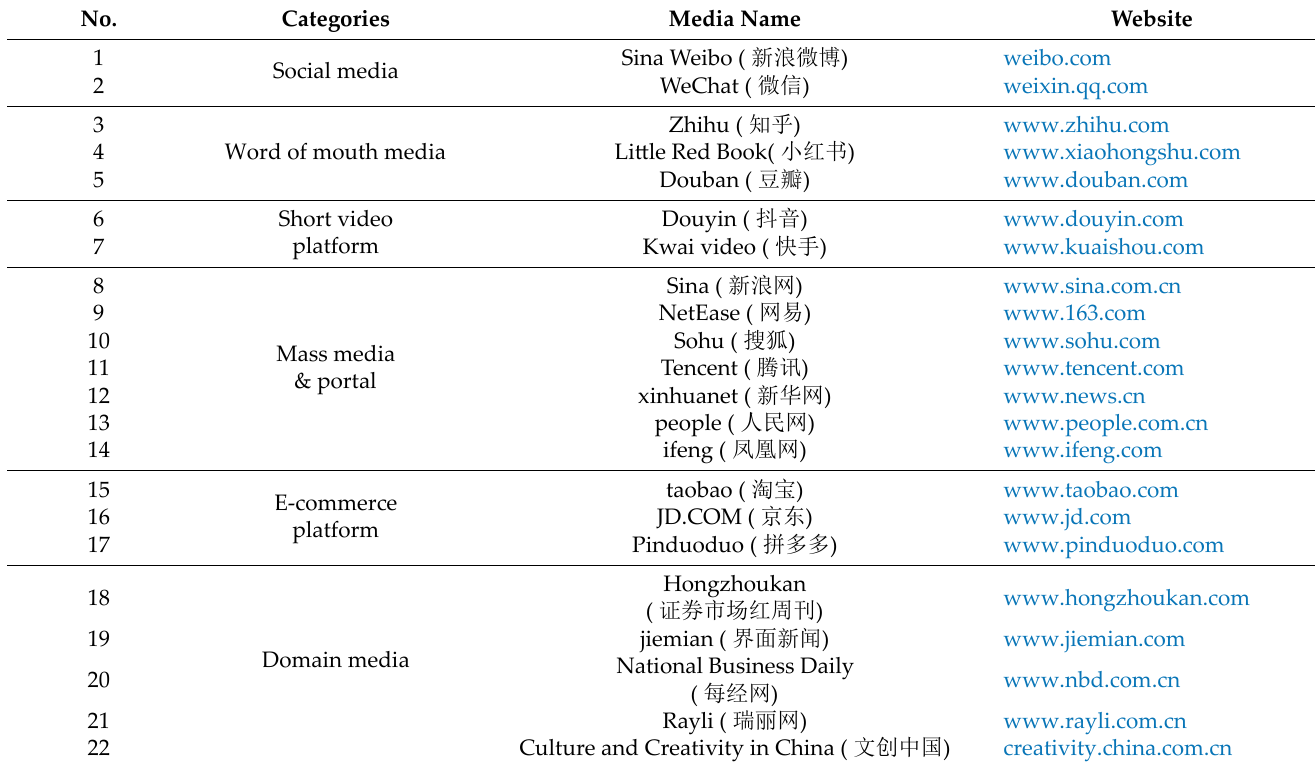
Table 1. Internet Media for the Data